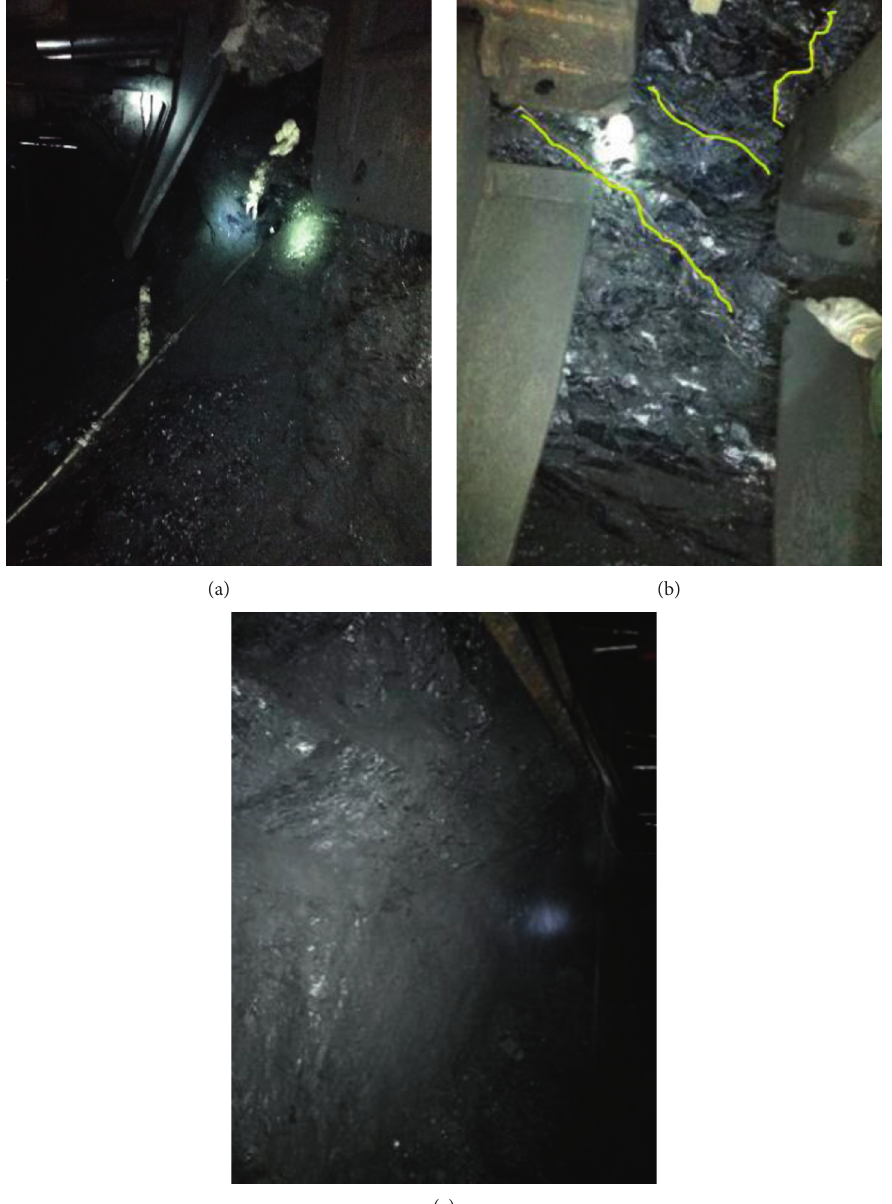
Figure 13: Stability of coal wall before and after grouting. (a) Broken coal wall before grouting. (b) Grout seepage lines. (c) Smooth coal wall after grouting